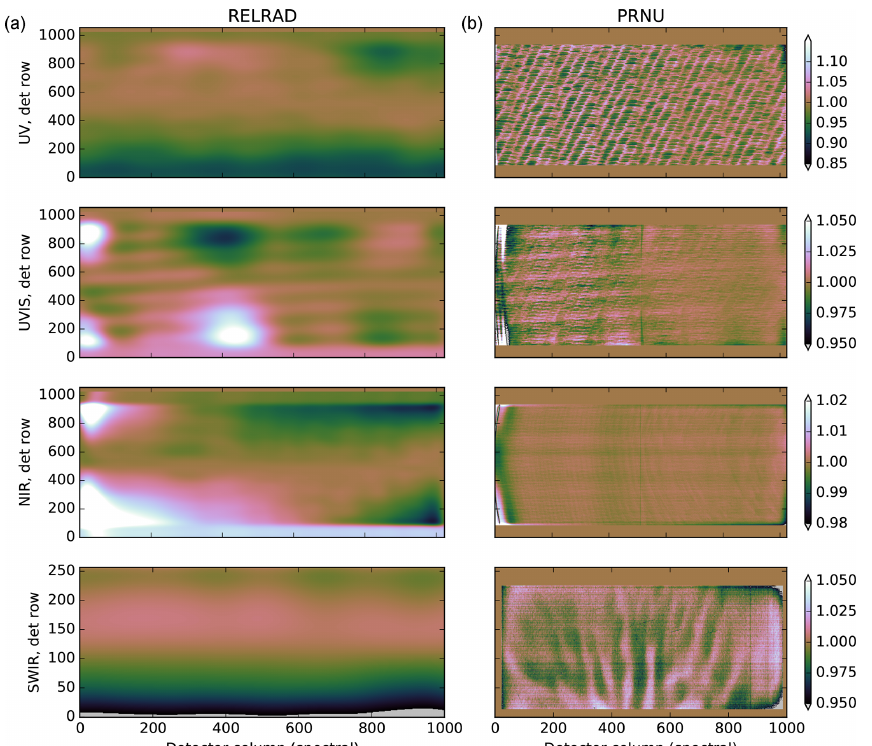
Figure 19. (a) The relative radiance response as a function of the detector pixels (horizontal axis the detector column, vertical axis the detector row) for each detector. At the reference row the response is set to unity. (b) The PRNU for each detector as a function of the detector